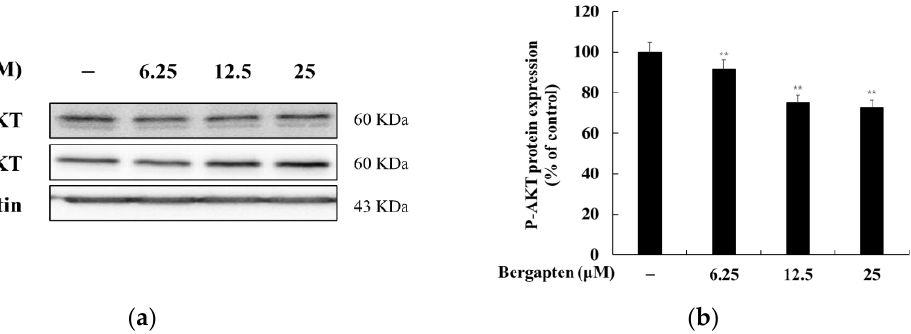
Figure 7. Effects of bergapten on the phosphorylation level of AKT in B16F10 melanoma cells. The cells were treated with bergapten (6.25, 12.5, and 25 μM) for 4 h. ( a ) Western blotting results and protein expression of ( b ) P-AKT/T- AKT. β -actin was used as a loading control. The results are presented as the mean ± SD of three independent measurements using Image J. ** p < 0.01 vs. the untreated group.